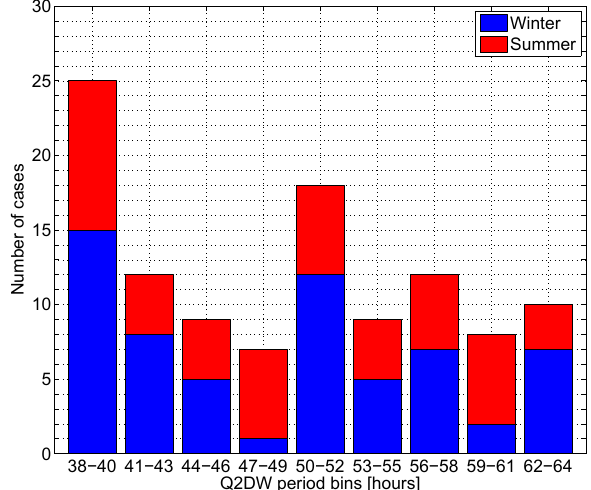
Figure 6. Histogram of Q2DW periods observed with the MIAWARA water vapor radiometer. Shown are the number of cases versus period bins with 3h width in which Q2DW events could be identified. The selected criterion of a Q2DW event was a localized maximum in a monthly averaged H 2 O wave spectrum exceeding 0 . 15ppm. The bar plots are stacked, which divides them into winter (blue) and summer (red)